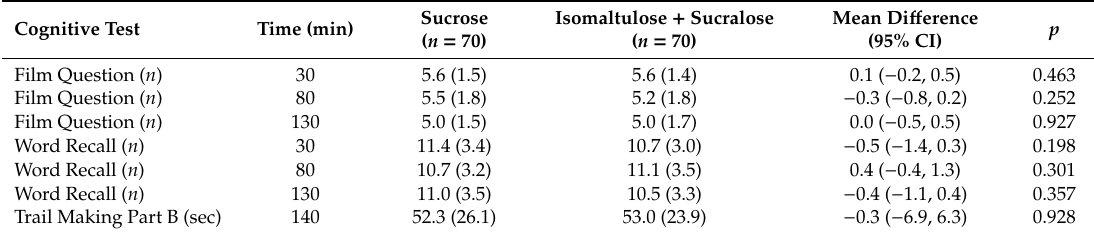
Table 1. Adjusted mean (SD) di ff erence of cognitive test results between sugars over three